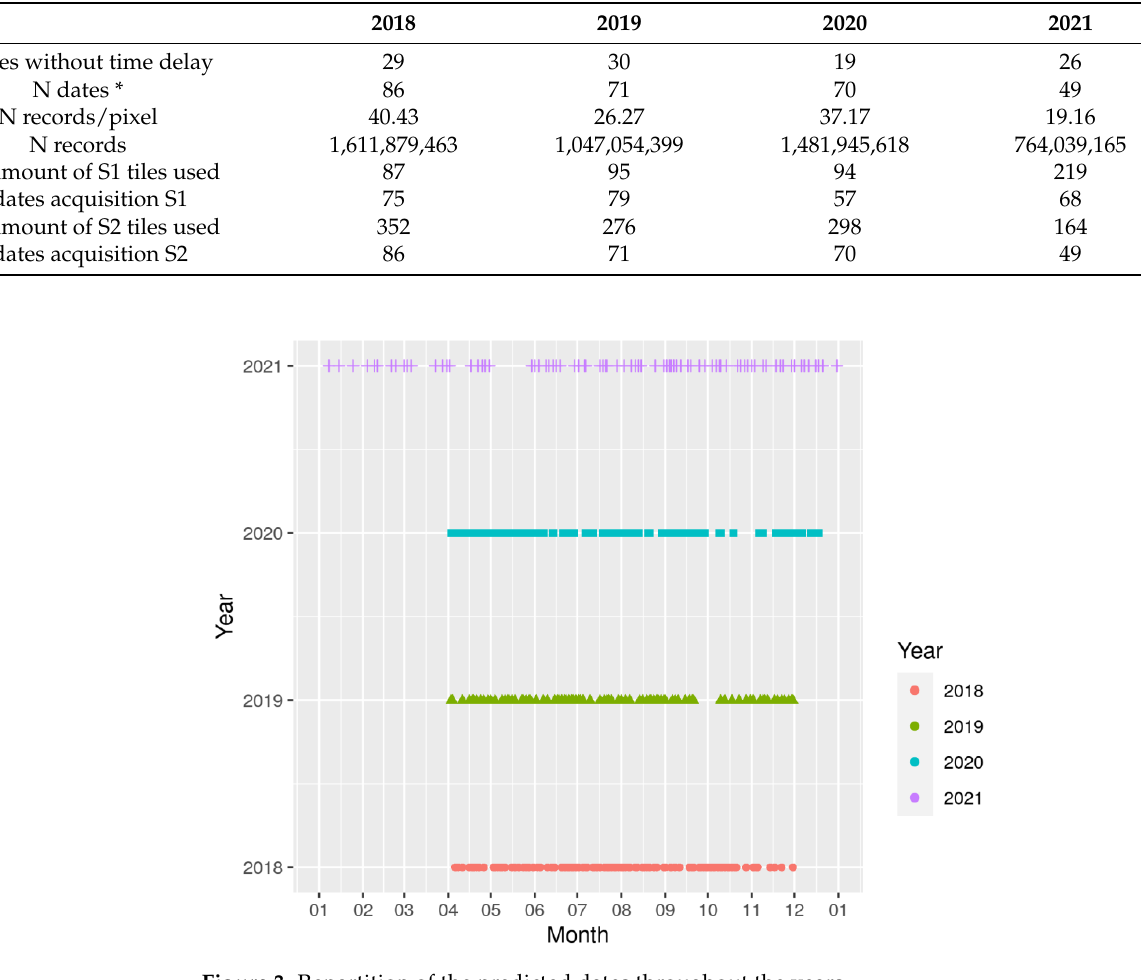
Figure 3. Repartition of the predicted dates throughout the years.